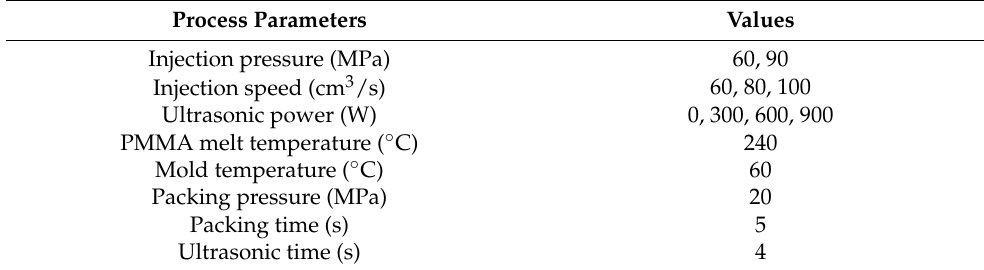
Table 1. Injection molding process parameters.